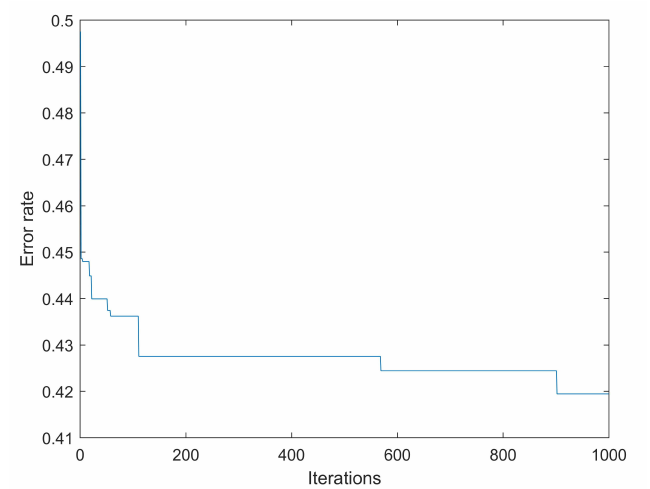
Figure 3. Example of the evolution of the error rate as the number of iterations increases.